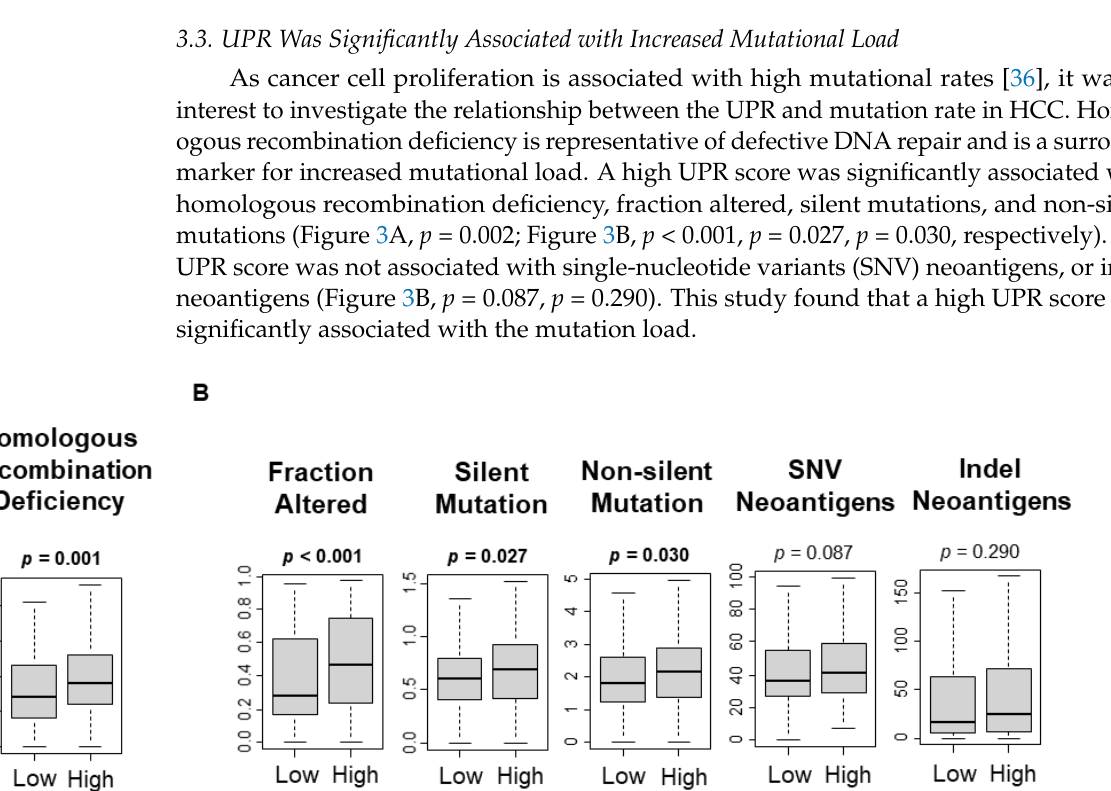
Figure 3. Association between Unfolded Protein Response and mutation-related scores. Boxplots of the comparison of the high vs. low unfolded protein response and ( A ) homologous recombinant defects score; ( B ) fraction altered, silent mutation, non-silent mutation, single-nucleotide variants (SNV) neoantigens, and indel neoantigens. The p -value was calculated using the Mann – Whitney U test. Bold format: significant p values.